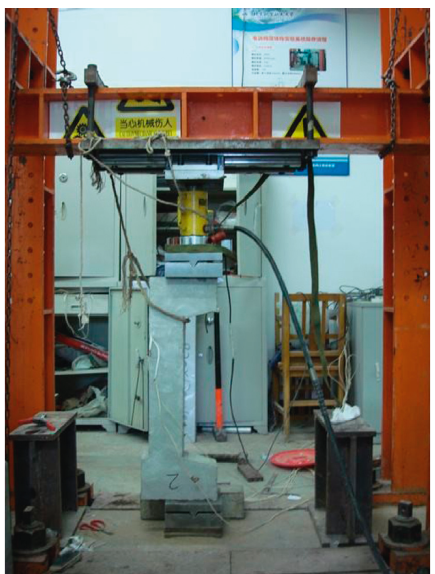
Figure 2: Setup of static eccentric loading